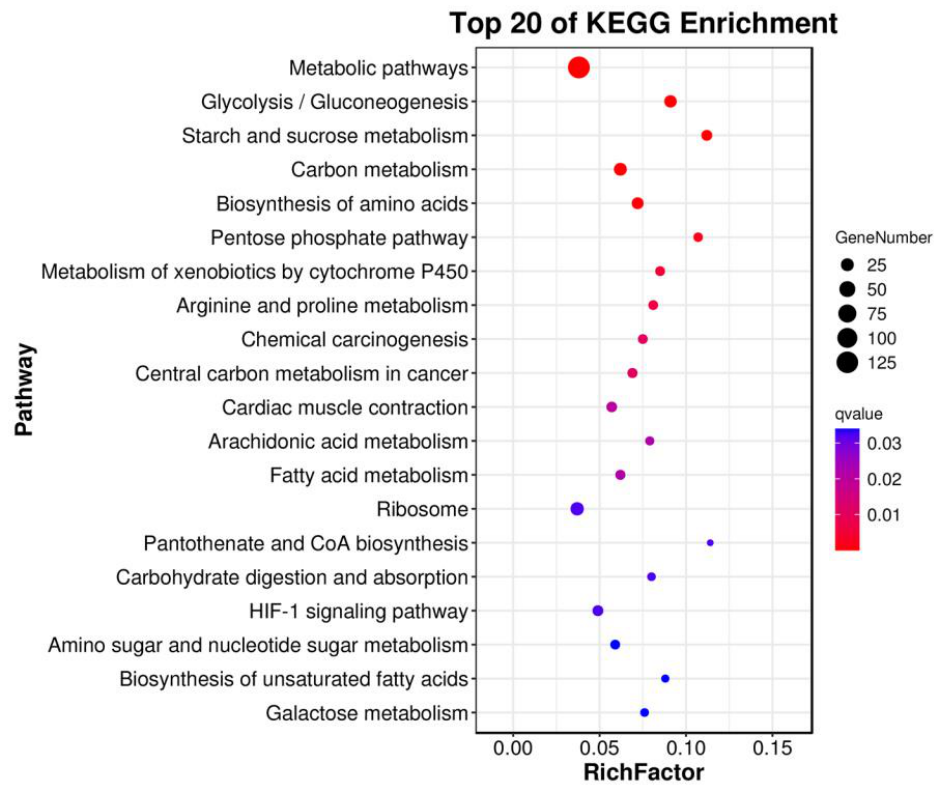
Figure 2. The most enriched pathways of the differentially expressed genes in the hepatopancreas of Palaemon carinicauda after EHP infection.